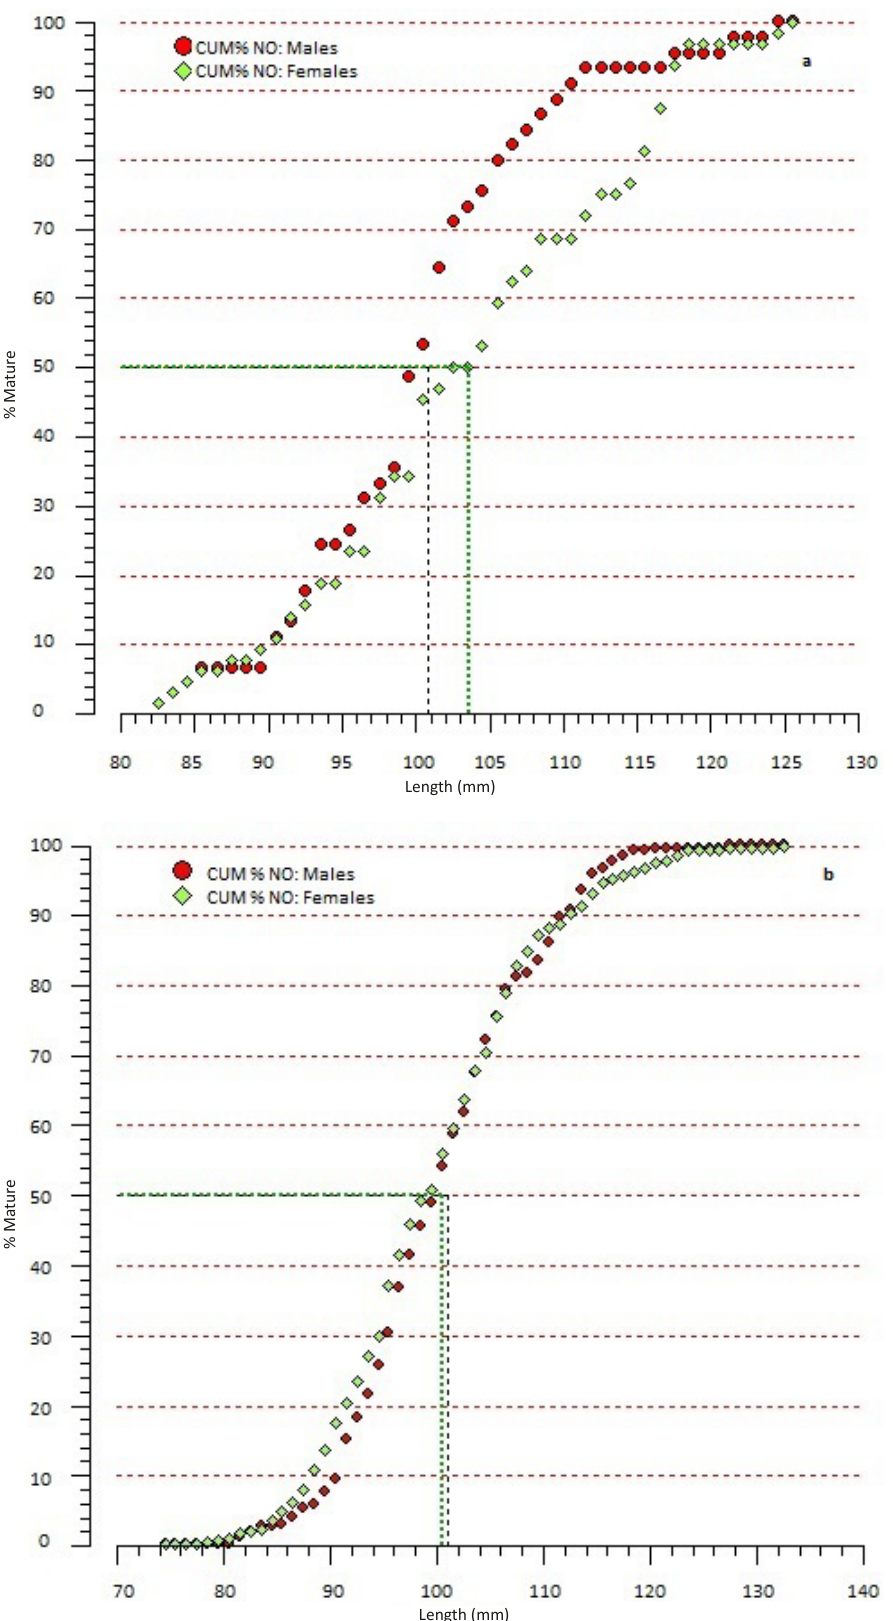
Figure 5. Mean length at first maturity (SL